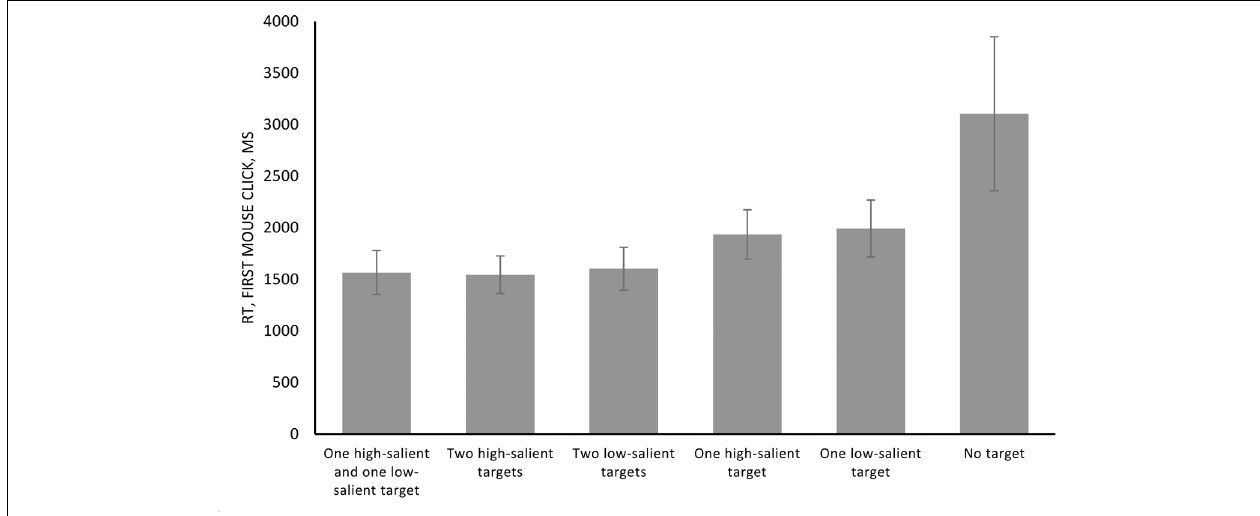
FIGURE 3 | Mean reaction time (ms) of the first mouse click collapsing different stimulation conditions. Error bars represent standard error of the mean. TABLE 3 | Means and standard deviations (SD) in reaction time (ms) of the first mouse click for different stimulation conditions.